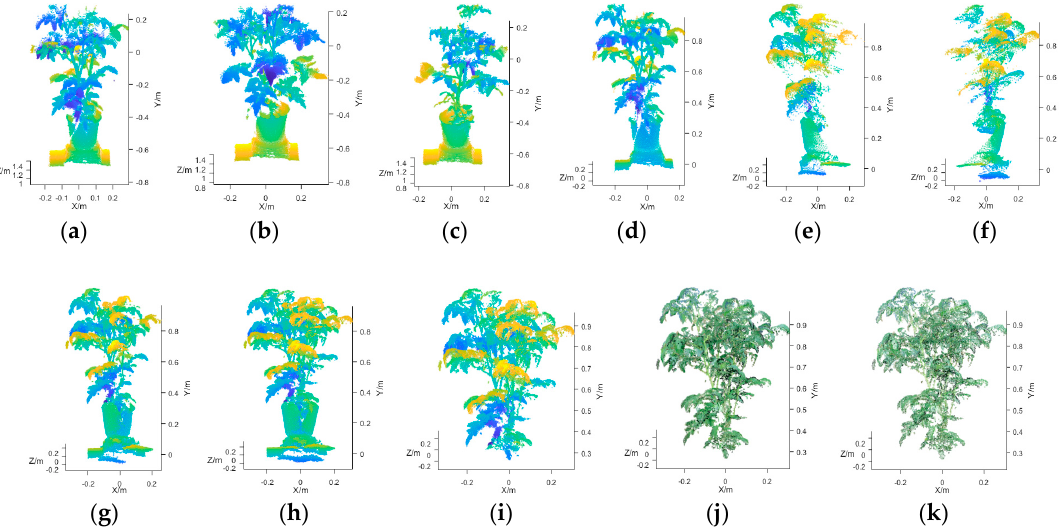
Figure 4. 3D point cloud reconstructions of greenhouse tomato plants (GTPs): ( a ) 0° point cloud; ( b ) 120° point cloud; ( c ) 240° point cloud; ( d ) 0° point cloud transformation; ( e ) 120° point cloud ( b ) 120 ◦ point cloud; ( c ) 240 ◦ point cloud; ( d ) 0 ◦ point cloud transformation; ( e ) 120 ◦ point cloud transformation; ( f ) 240° point cloud transformation; ( g ) iterative closest point (ICP) (0°, 120°); ( h ) transformation; ( f ) 240 ◦ point cloud transformation; ( g ) iterative closest point (ICP) (0 ◦ , 120 ◦ ); ( h ) ICP ICP (0°, 120°, 240°); ( i ) canopy area (depth map); ( j ) canopy area (RGB); ( k ) point cloud (0 ◦ , 120 ◦ , 240 ◦ ); ( i ) canopy area (depth map); ( j ) canopy area (RGB); ( k ) point cloud down-sampling.